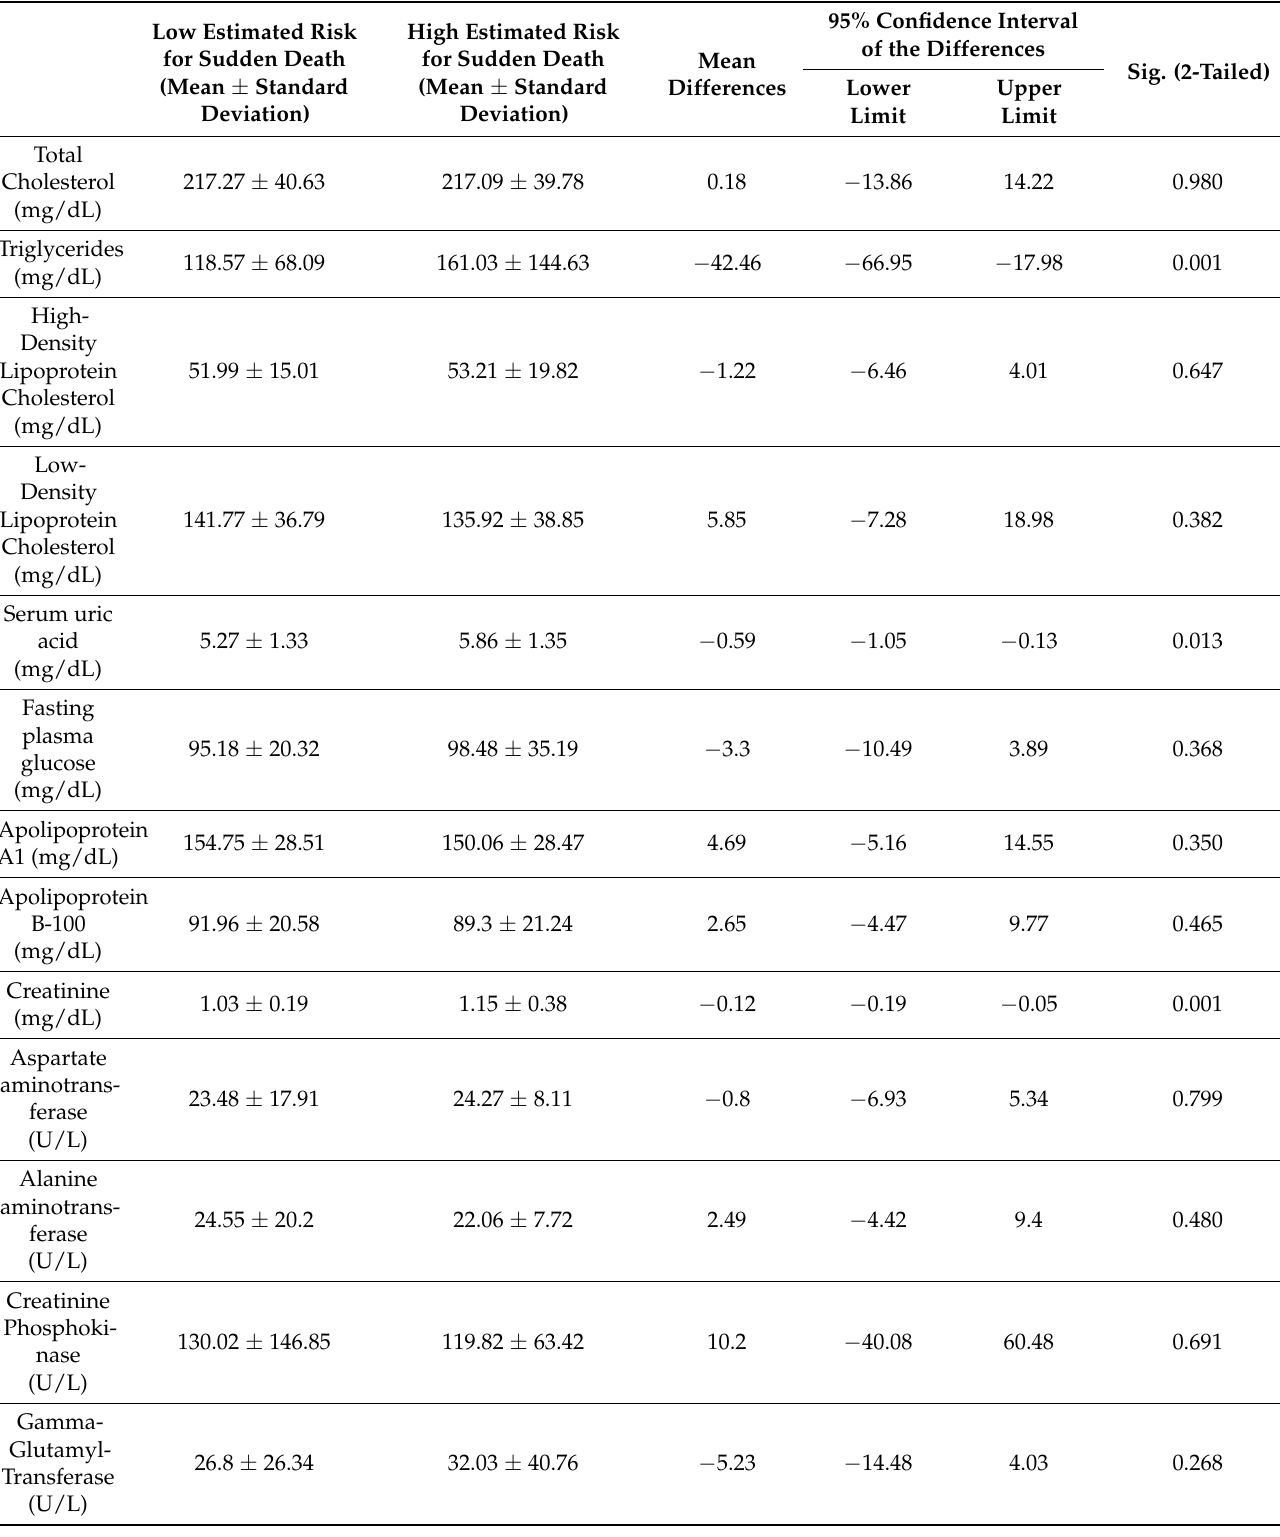
Table 5. Descriptive and comparative analysis of laboratory parameters of the investigated